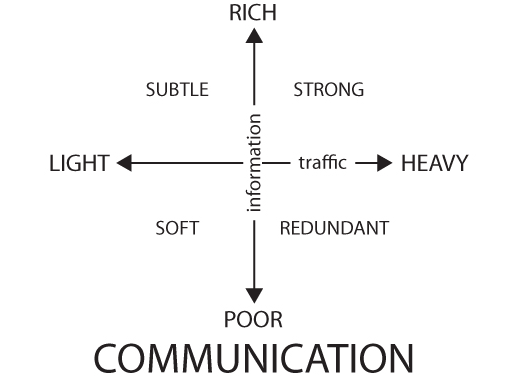
Figure 3. Our proposal for a communication classification along the axis of information and traffic. Traffic refers to the size of the message that is sent. The information axis considers the impact of that message in the